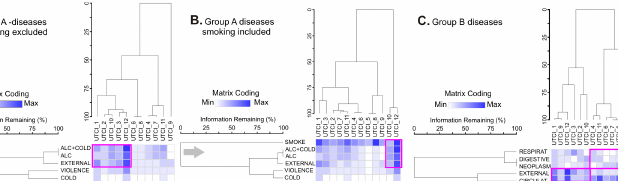
Fig 3. Two-way cluster (bi-cluster) diagram of the monthly UTC indices and a number of deaths among the homeless as a result of group A causes excluding smoking (A), group A causeswith smoking (B) and group B causes(C). Abbreviations referring to causes of death correspond to those in Table 2. UTCI and cause clusters are basedon Euclideandistancemeasuresand Ward’s linkingmethod. The shadingof each box represents a relativecontributionof the number of deaths in a column. Diseases abbreviations: see Table 2.